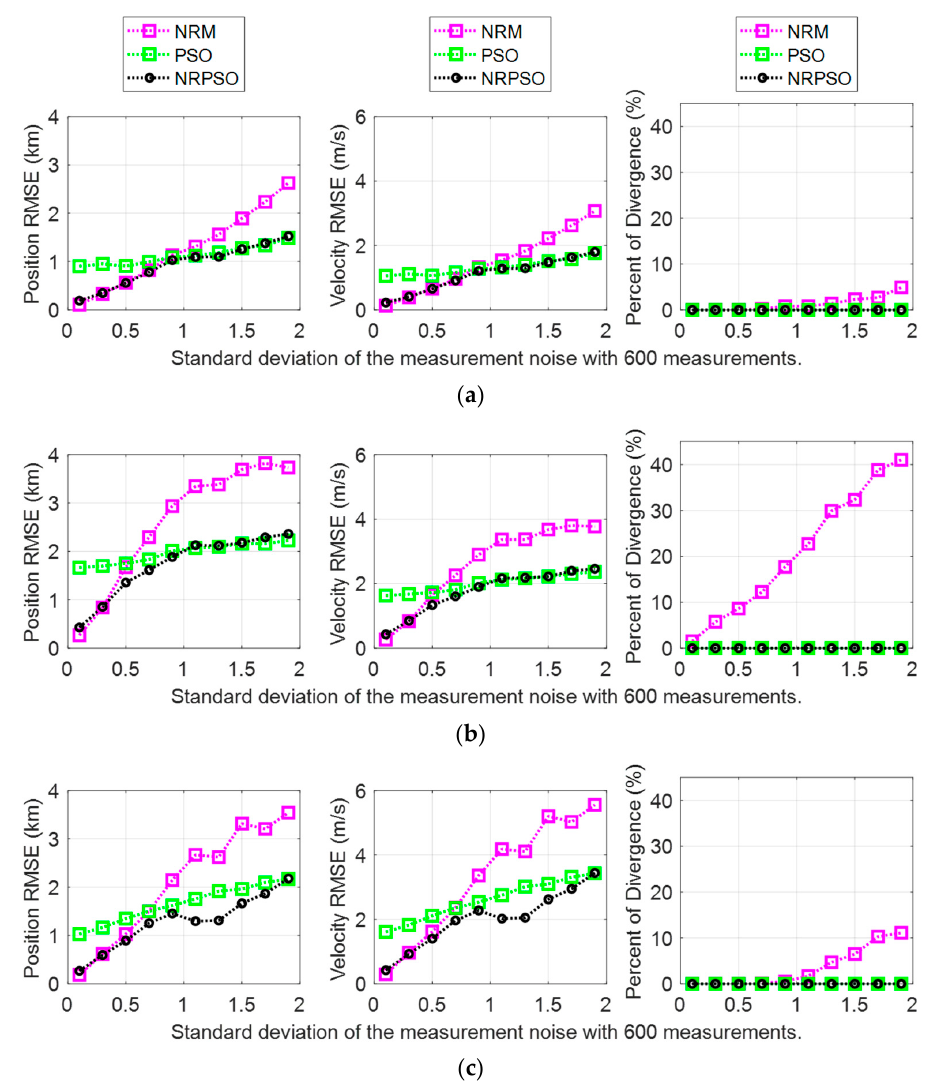
Figure 4. Bearing-only target motion analysis (BO-TMA) results versus measurement noise standard deviation for ( a ) Target 1, ( b ) Target 2, and ( c ) Target 3. The results of the Newton–Raphson method (NRM), particle swarm optimization (PSO), and NRPSO are represented by magenta, green, and black, respectively. The left column indicates the position RMSE, the center column shows the velocity RMSE, and the right column shows the rate of divergence. The BO-TMA performance was also confirmed using various numbers of measure- ments according to the sampling period with a measurement noise of 𝜎 = 0.5 °. These re- sults are shown in Figure 5. The measurement noise was assumed to be a zero mean